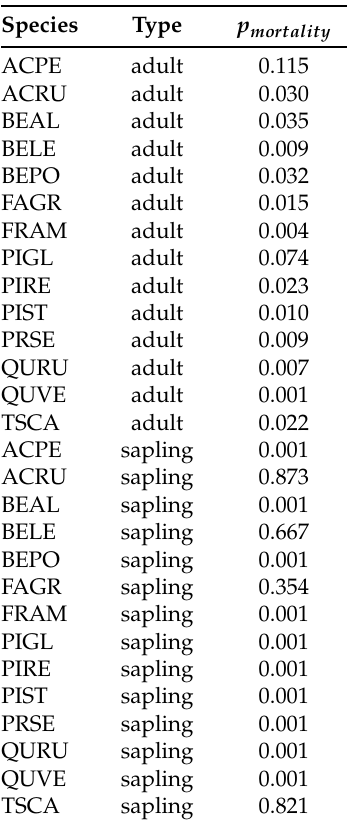
Table A5. Species mortality